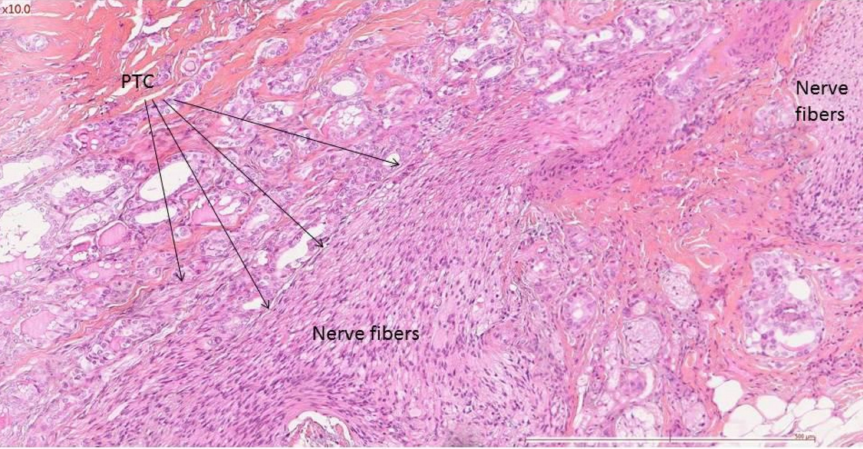
Figure 1. Classic papillary thyroid carcinoma (PTC) in contact with nerve fibers (Schwann